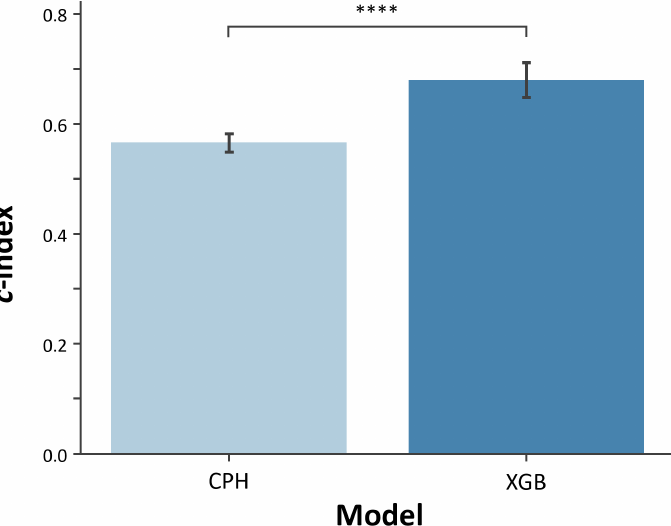
Figure 2. Mean c -index of the CPH and XGB models using tenfold cross-validation. Error bars represent the 95% confidence intervals across folds. **** p < 0.0001.